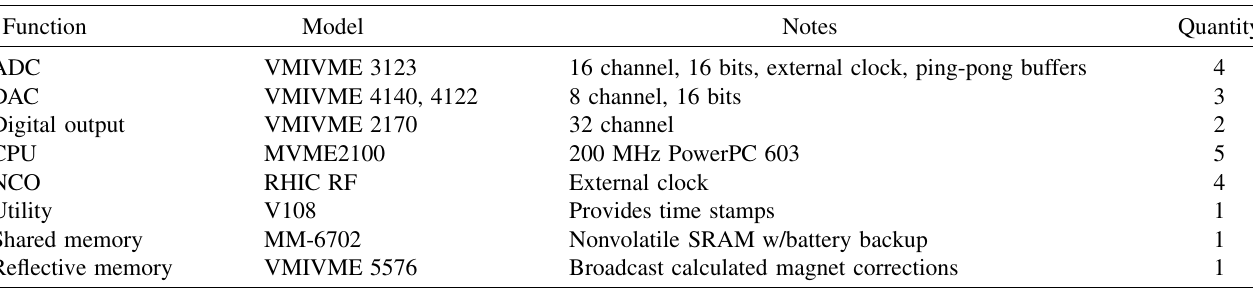
TABLE I. VME modules used in the tuned feedback